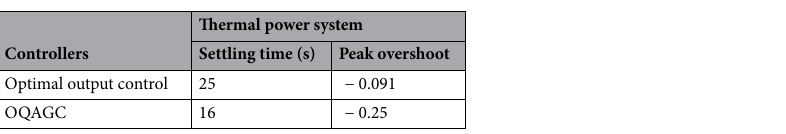
Table 11. Comparative study of overshoot with and without GRC for tie line power deviations 43 .